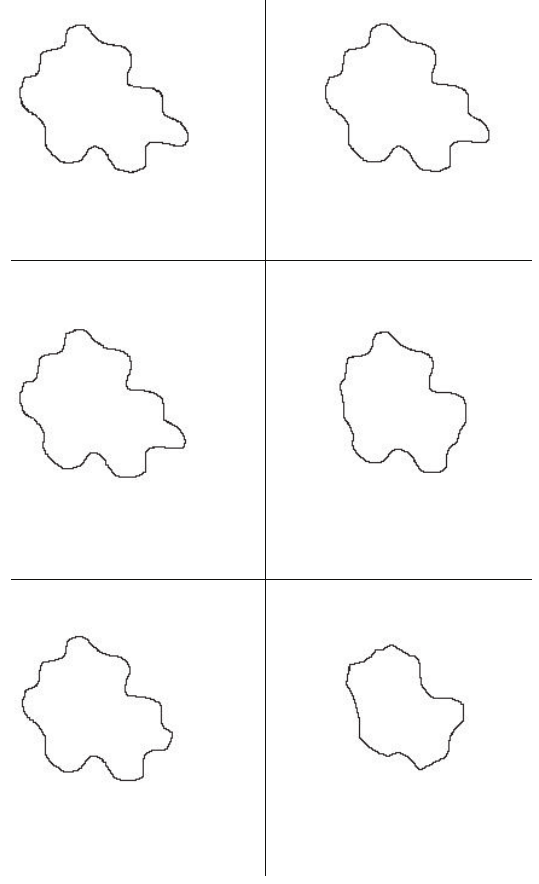
Figure 3: Test 1: Comparisons between segmentation results. On the left Algorithm I. On the right Algorithm SI. First row: Δ τ I = 0 . 4, Δ τ SI = 0 . 16. Second row: Δ τ I = 0 . 04, Δ τ SI = 0 . 16. Third row: Δ τ = 0 . 004, Δ τ = 0 . 0016. I I